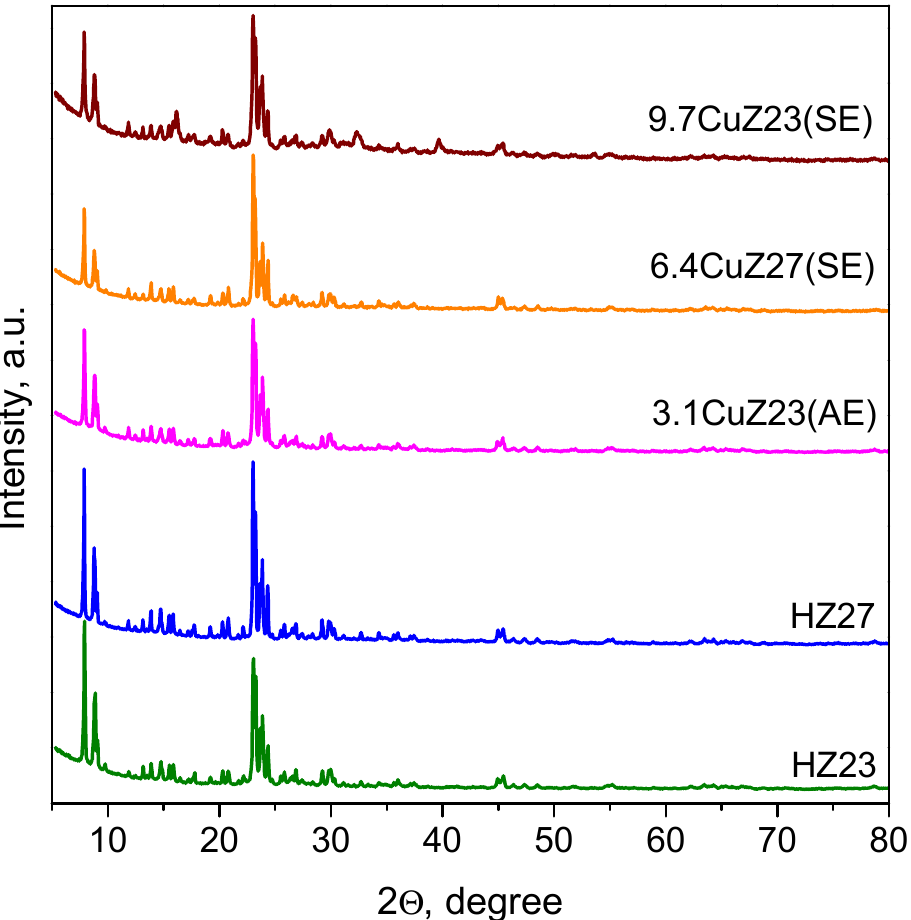
Figure 1. XRD profiles of the parent and the Cu-exchanged zeolites. After the ion exchanges, the materials retain the size and morphology of their